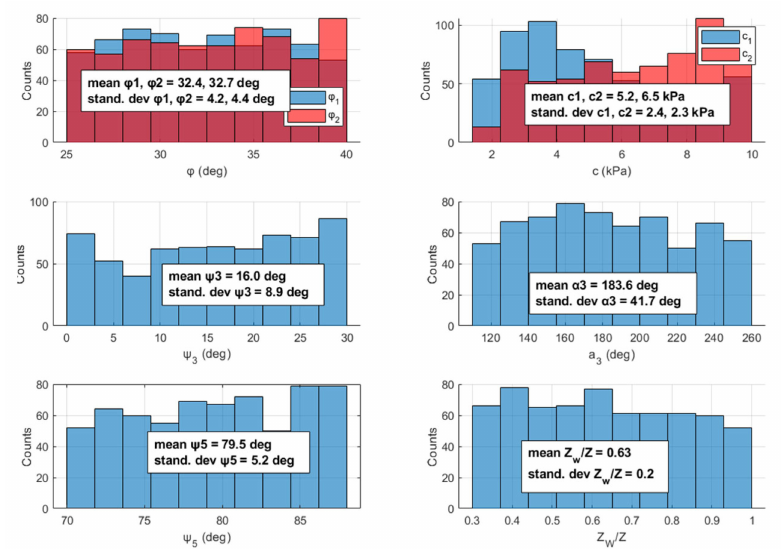
Figure 9. Results of back-analysis procedure for the critical plane intersections of wedge sliding, in terms of material strength properties of discontinuities and geometrical features of slopes, for slope dip direction ranging between 220 ◦ and 248 ◦